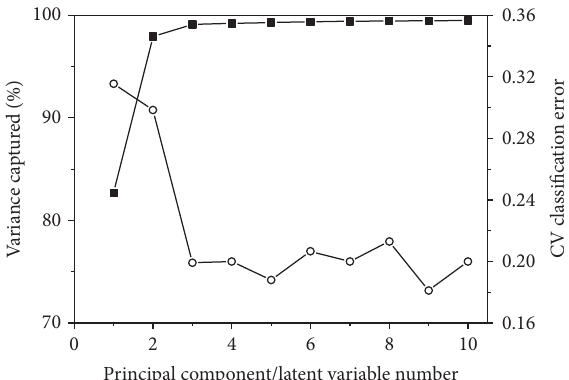
Figure 2: Variance captured percent and classification error as functionofmodelcomplexity(i.e.,retainednumberofPCsandLVs) using PCA-LDA and PLS-DA together with leave-one-patient-out